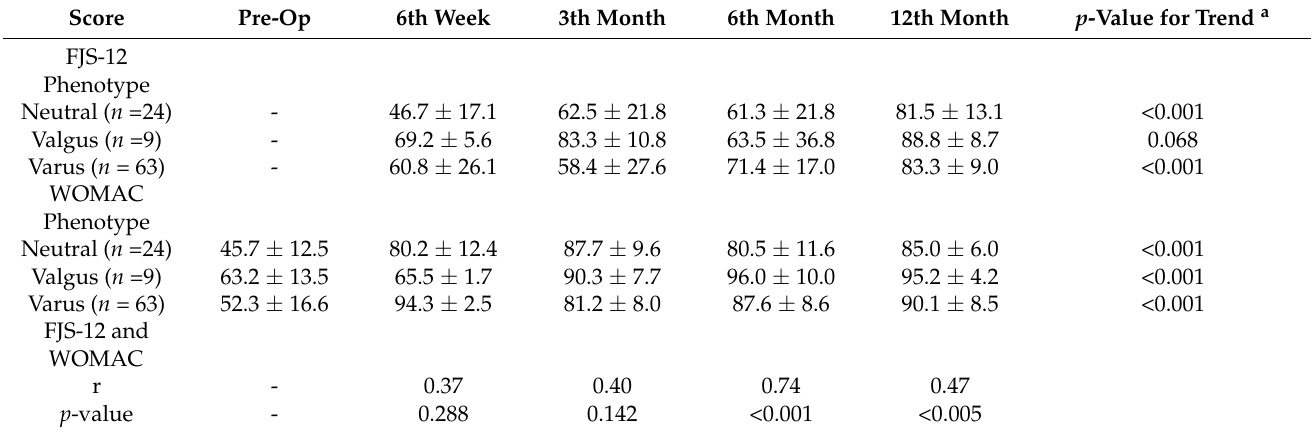
Table 3. Time course one year follow-up functional outcomes of FJS12 and WOMAC in different Huang’s